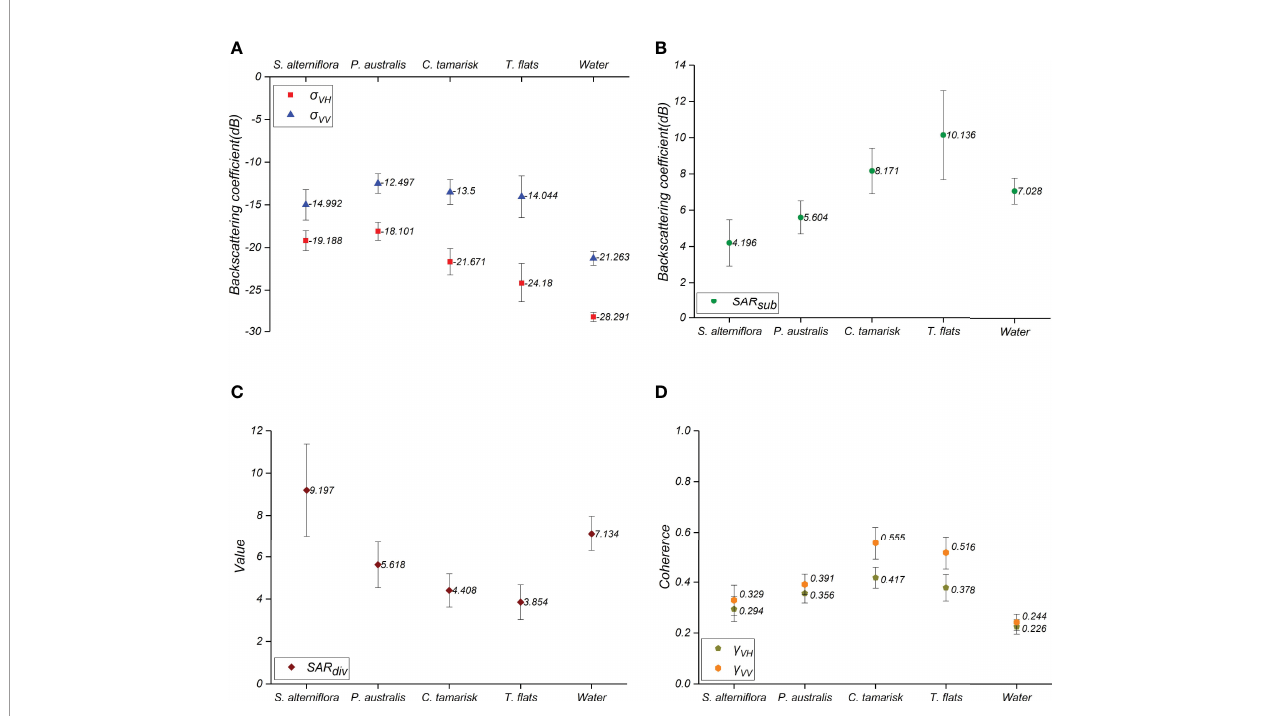
FIGURE 5 | Mean and standard deviation of characteristic parameters of fi ve objects through statistical analysis. (A) is the mean and standard deviation of VH and VV backscattering coef fi cients; (B) is the mean and standard deviation of radar index SAR sub ; (C) is the mean and standard deviation of radar index SAR div ; (D) is the mean and standard deviation of VH and VV